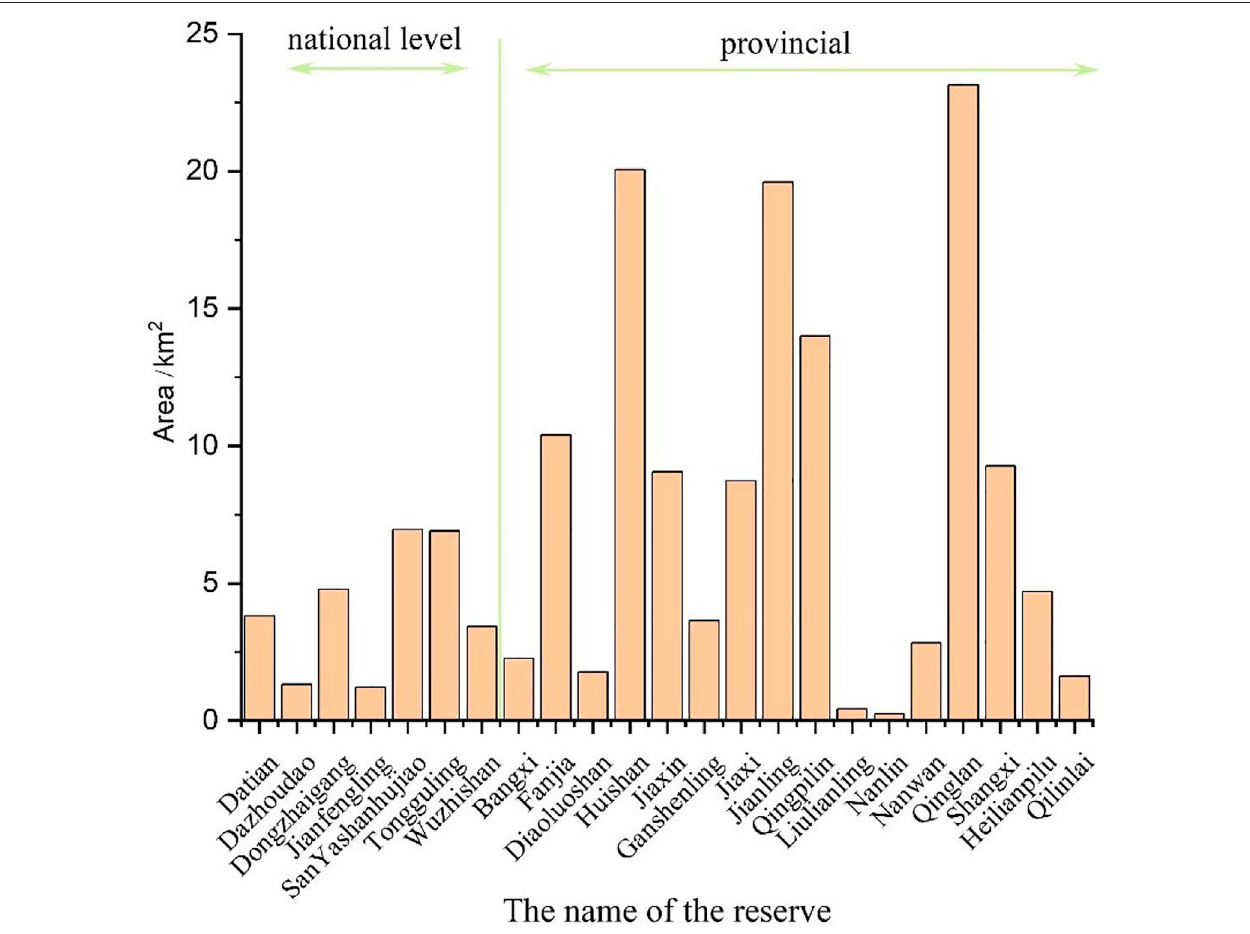
FIGURE 6 | Forest disturbance area of different levels of nature